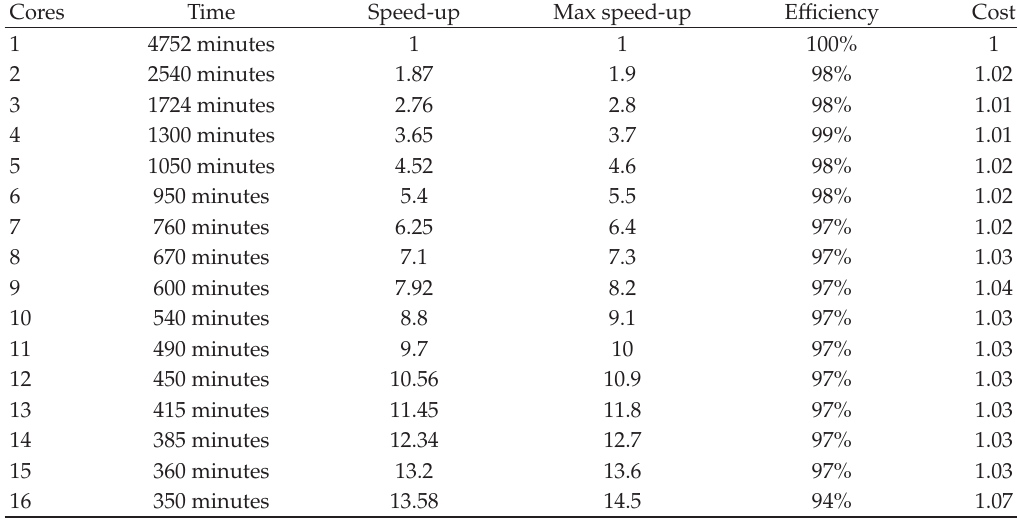
Table 3: Performance Metrics using JPVM over the cluster.